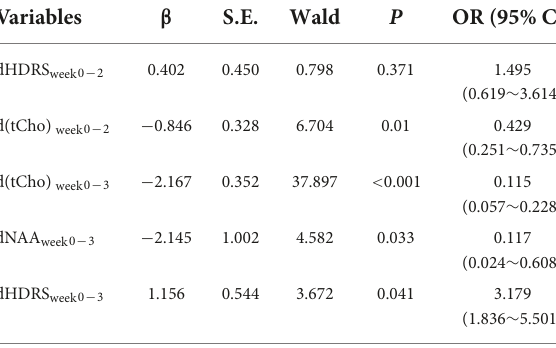
TABLE 2 Logistic regression analysis in check point week 2 and week